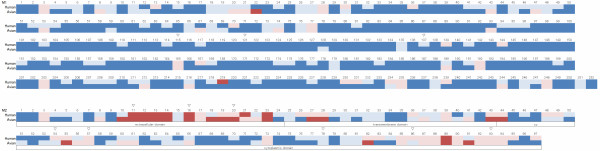
Summary of site-by-site analyses. The figure shows the positive or negative selection in human and avian influenza, and differences in consensus sequences between the hosts. Amino acid positions under positive and negative selection are shaded in red and blue, respectively. Sites under significant positive and negative selection are shaded in dark colors, while light colors indicate no significance. Triangles indicate sites where the consensus amino acids are different between human and avian influenza.